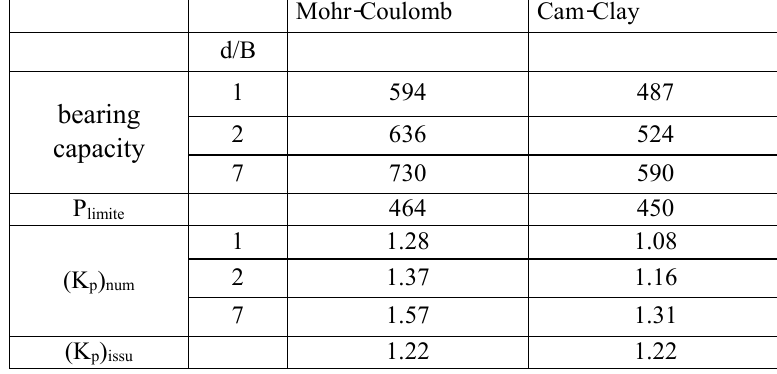
Digital estimation of the lift factor of the pressuremeter test.